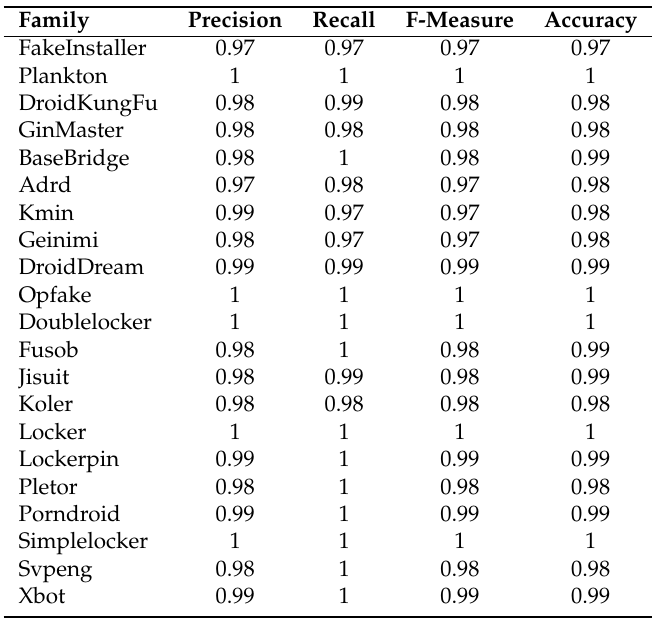
Table 5. Performance